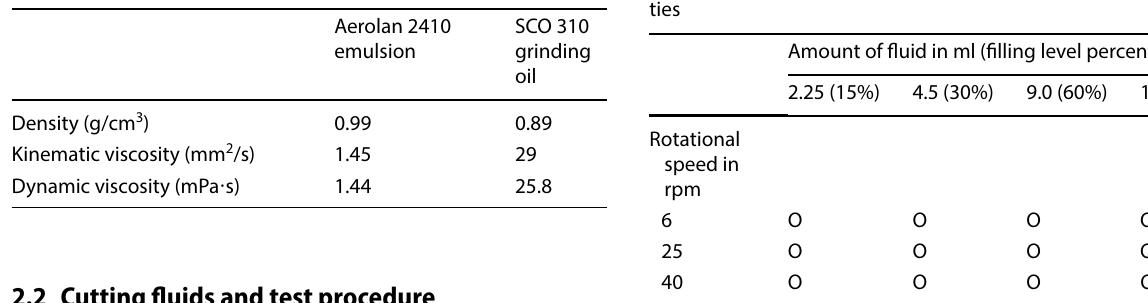
Table 1 Densities and viscosities of the tested cutting fluids at 20 °C